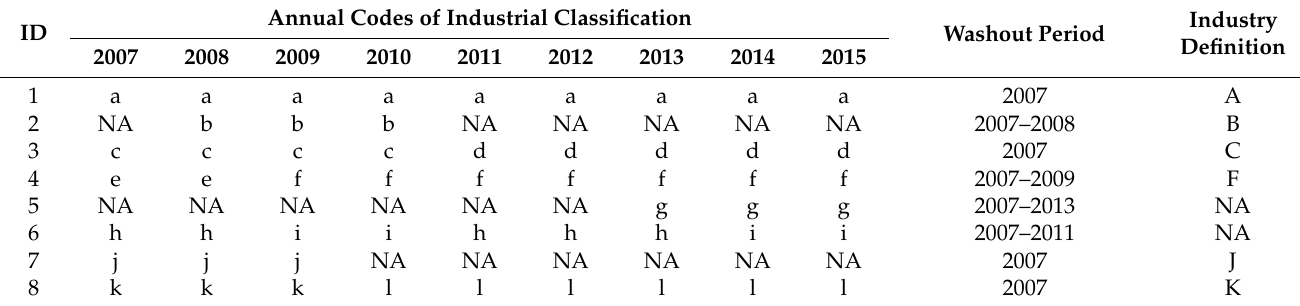
Table 1. Examples of industry definitions for workers in the study